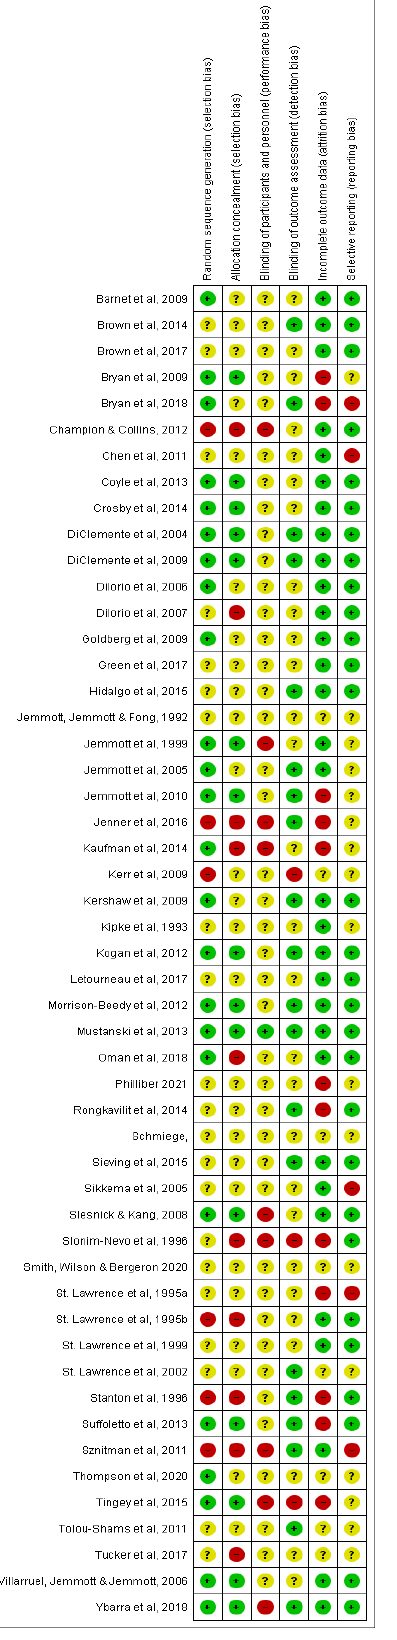
Figure 3. Risk of bias summary: review authors’ judgements about each risk of bias item for each included study.